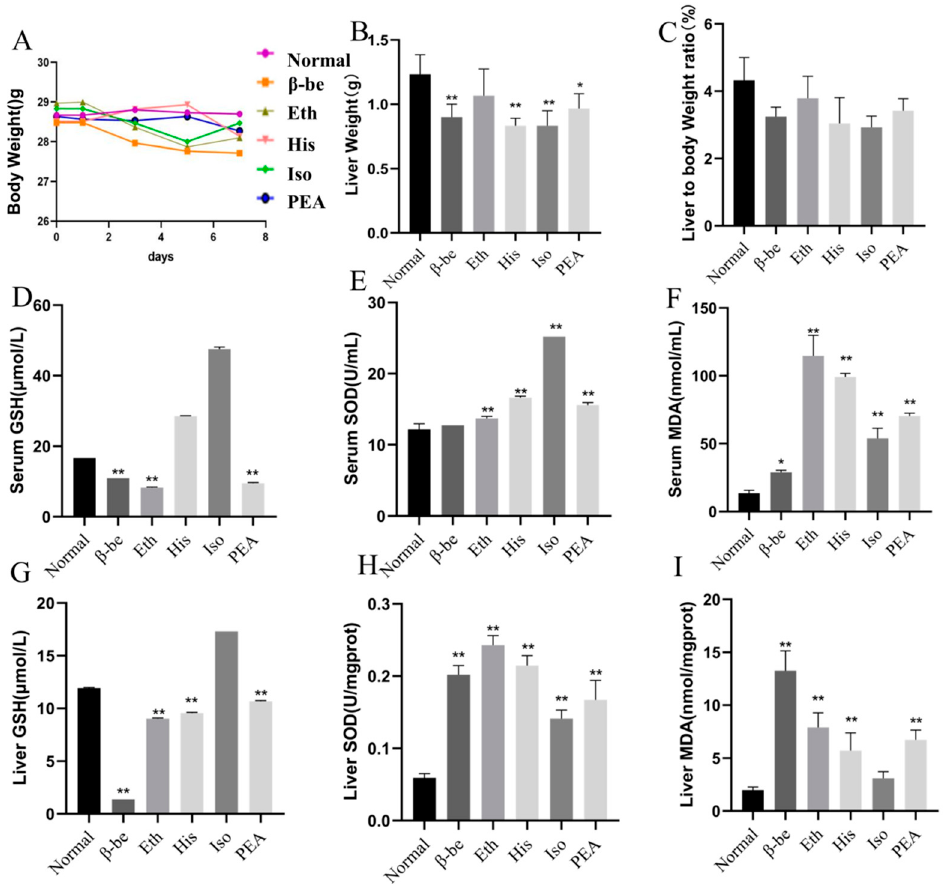
Figure 1. The effects of His, PEA, β -be, and Iso on body weight, liver weight, serum, and level of oxidative stress of mice. * p < 0.05, ** p < 0.01. ( A ) Changes in body weight. ( B ) Liver weight. ( C ) Liver to body weight ratio. ( D ) Serum GSH. ( E ) Serum SOD. ( F ) Serum MDA. ( G ) Liver GSH. ( H ) Liver SOD. ( I ) Liver MDA.